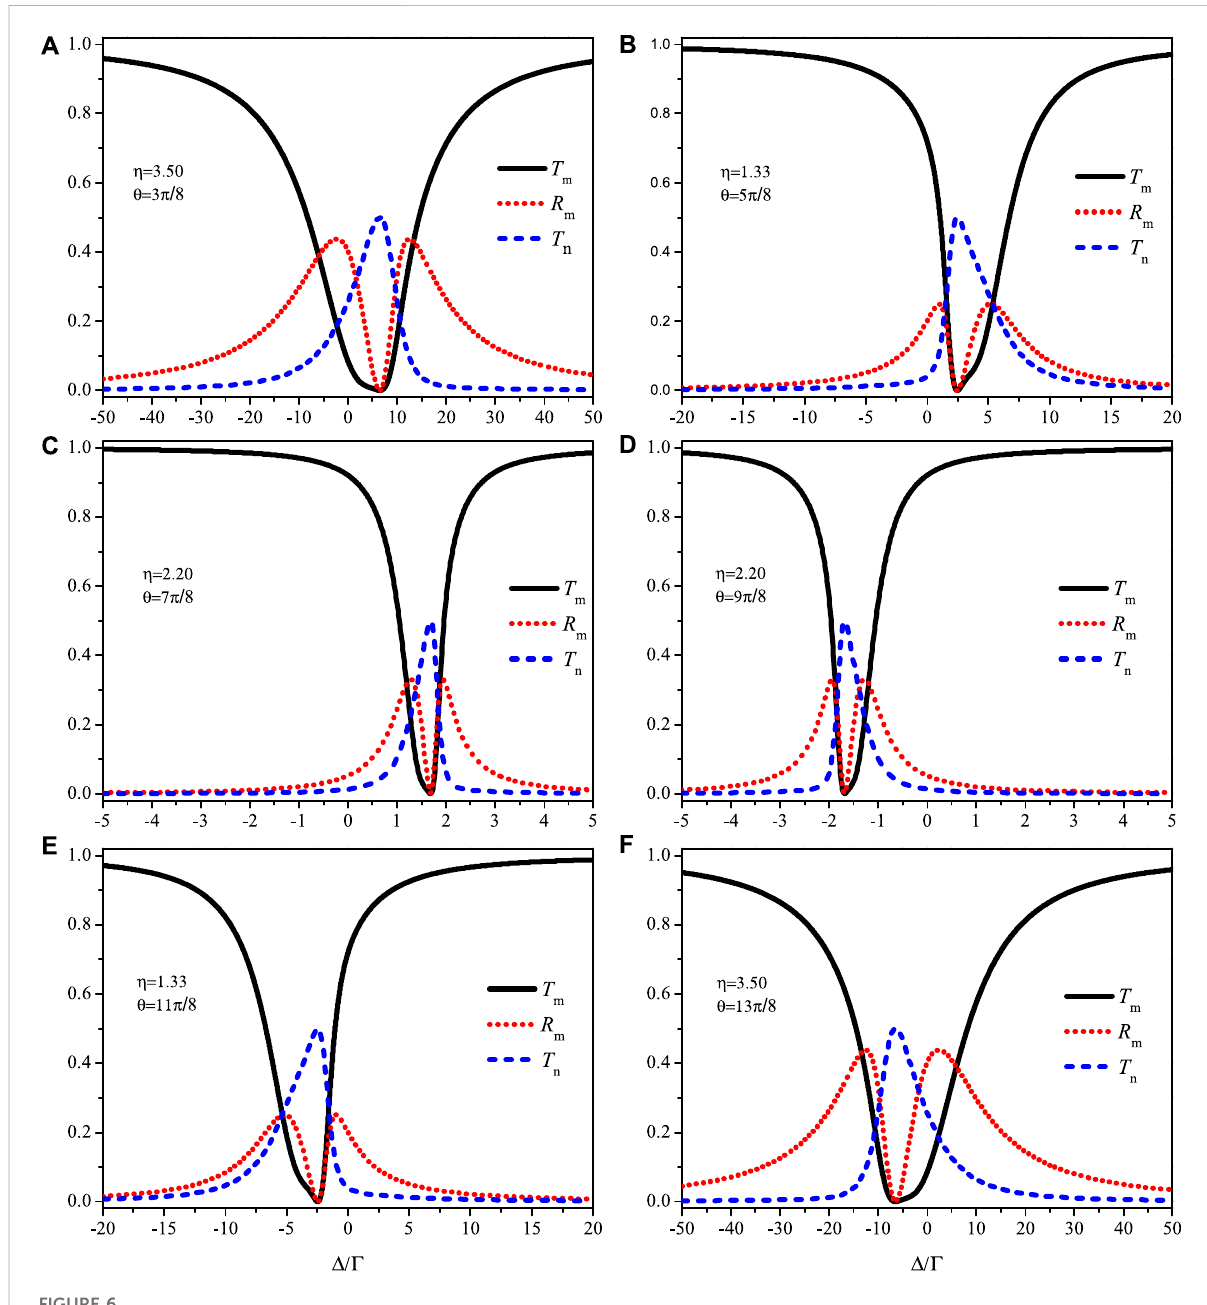
FIGURE 6 Transmission and re fl ection rates T m (dark solid line), T n (blue dashed line) and R m (red dotted line) as a function of Δ around the six extreme pointsshowninFigure5. (A) η =3.50, θ =3 π /8, (B) η =1.33, θ =5 π /8, (C) η =2.20, θ =7 π /8, (D) η =2.20, θ =9 π /8, (E) η =1.33, θ =11 π /8, (F) η =3.50, θ = 13 π /8.The transmitted spectraof T m and T n show asinglevalley orpeak,while there fl ected spectrumof R m exhibitstwopeaks.Thevalues of η and θ are provided by Table 1 and the interatomic interaction is not considered (g =